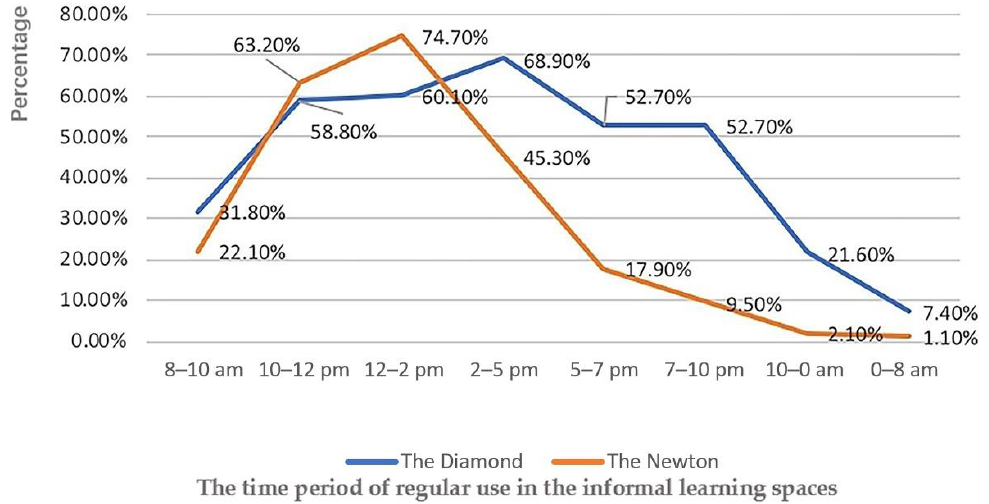
Figure 6. Percentage of students selecting time periods of when they regularly use informal learning spaces of Diamond and Newton, from questionnaire.